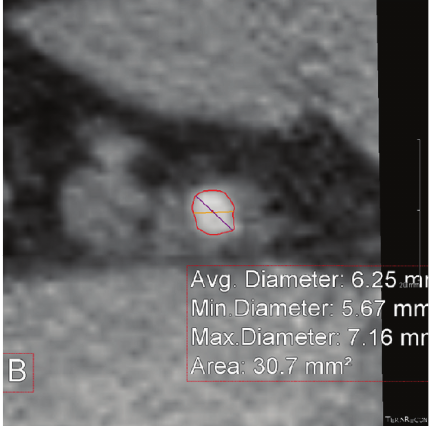
Figure 1: Contrasted enhanced CT scan images.